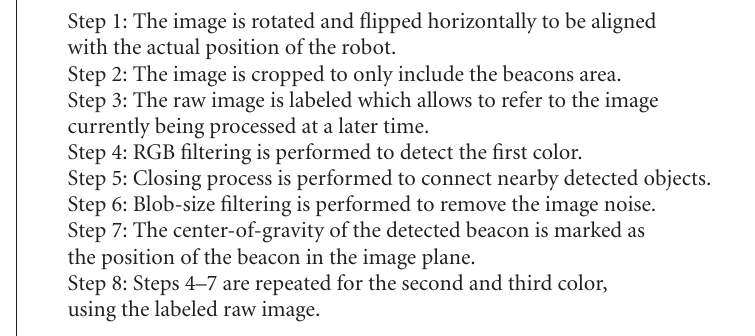
Algorithm 1: The real-time image-processing algorithm.